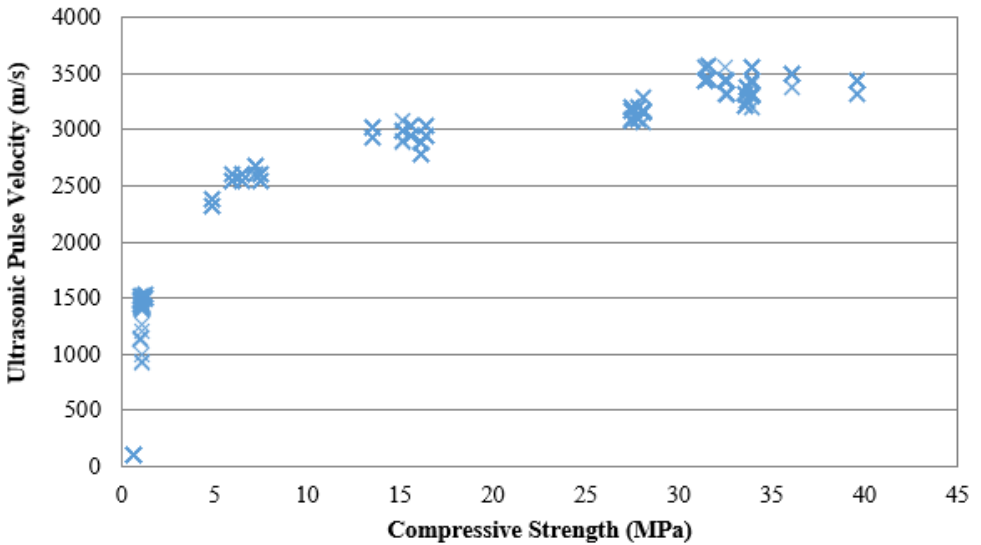
Figure 12. Relationship of ultrasonic pulse velocity and compressive strength (40 MPa).